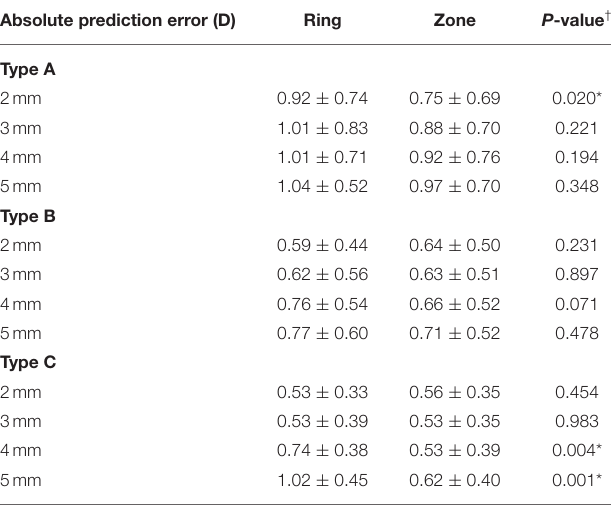
TABLE 4 | Prediction errors of corneal astigmatism based on the ring or zone mode centered on the corneal apex in eyes with a symmetric bowtie. Absolute prediction error (D)